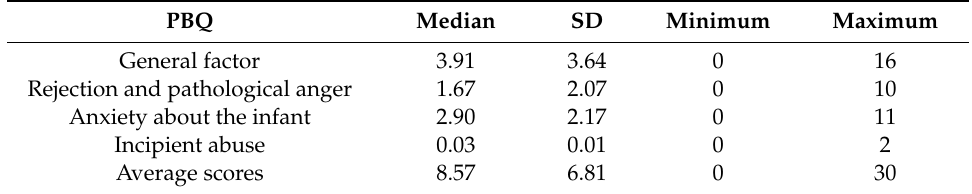
Table 2. Descriptive characteristics of maternal–infant bonding (PBQ) of the study group ( n = 150).